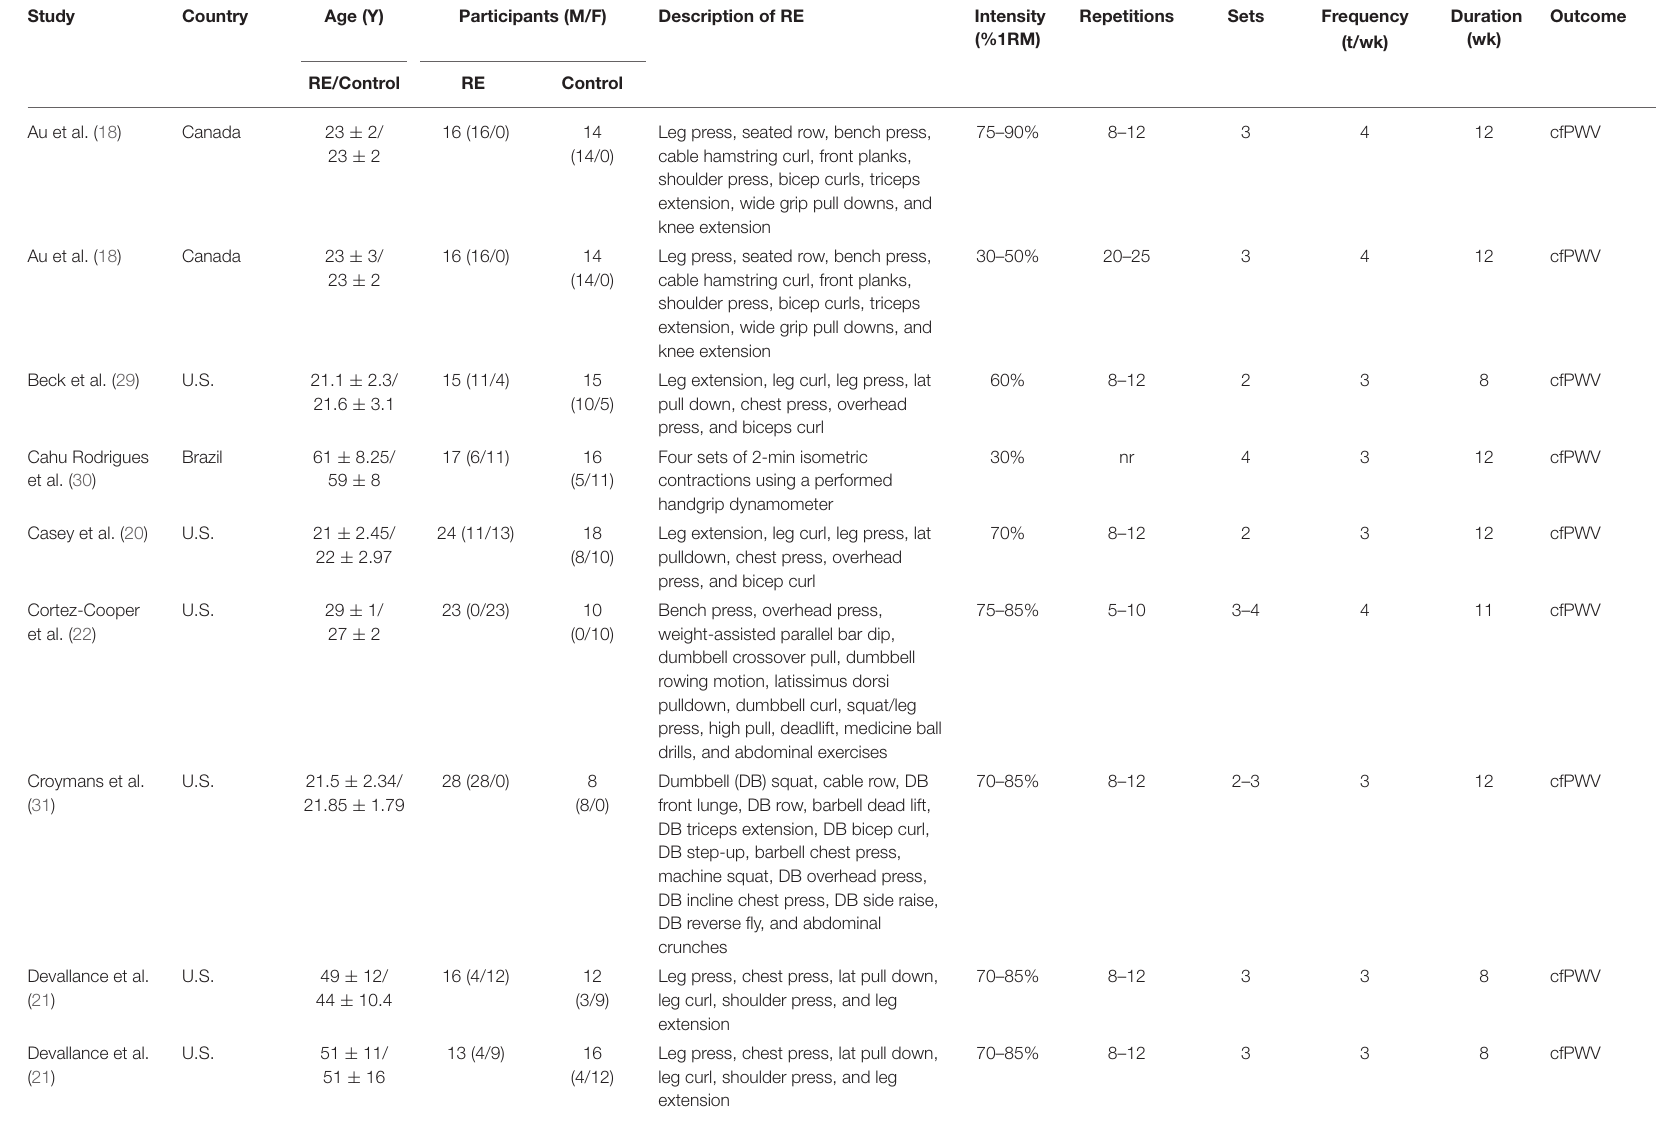
TABLE 1 | Characteristics of the included studies.